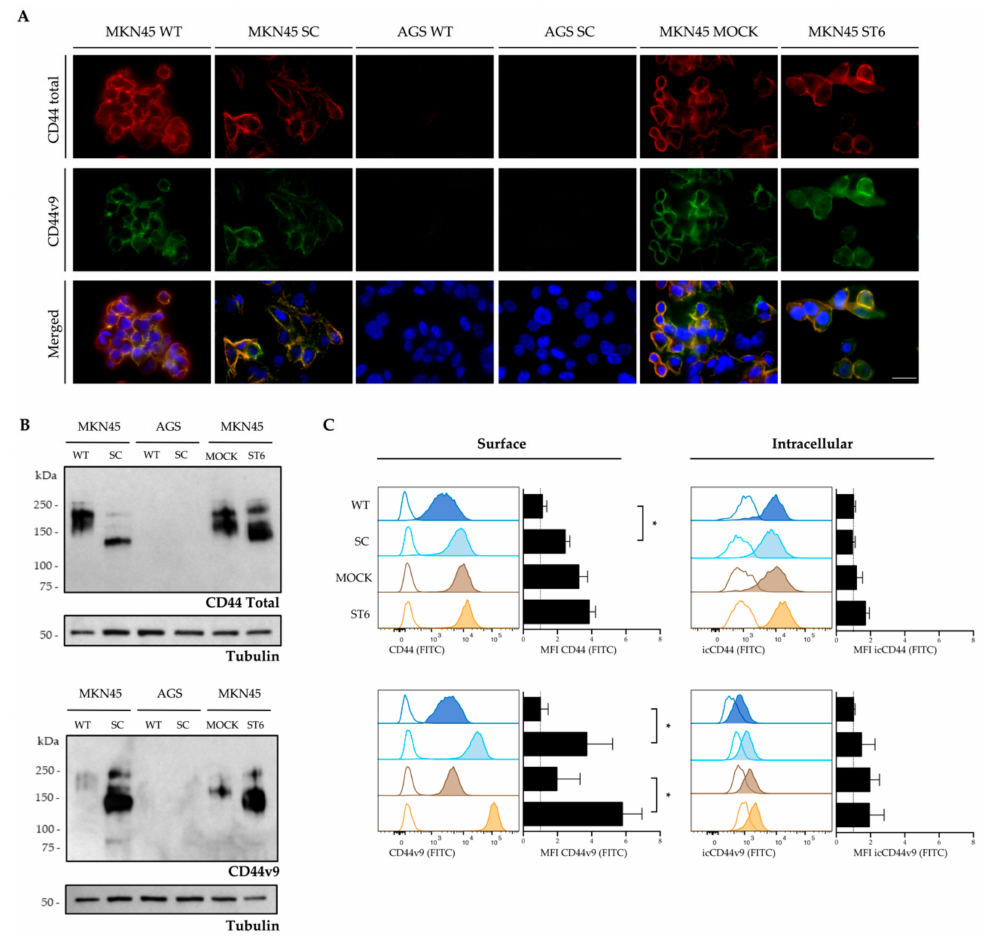
Figure 3. CD44v9 in a truncated O -glycan